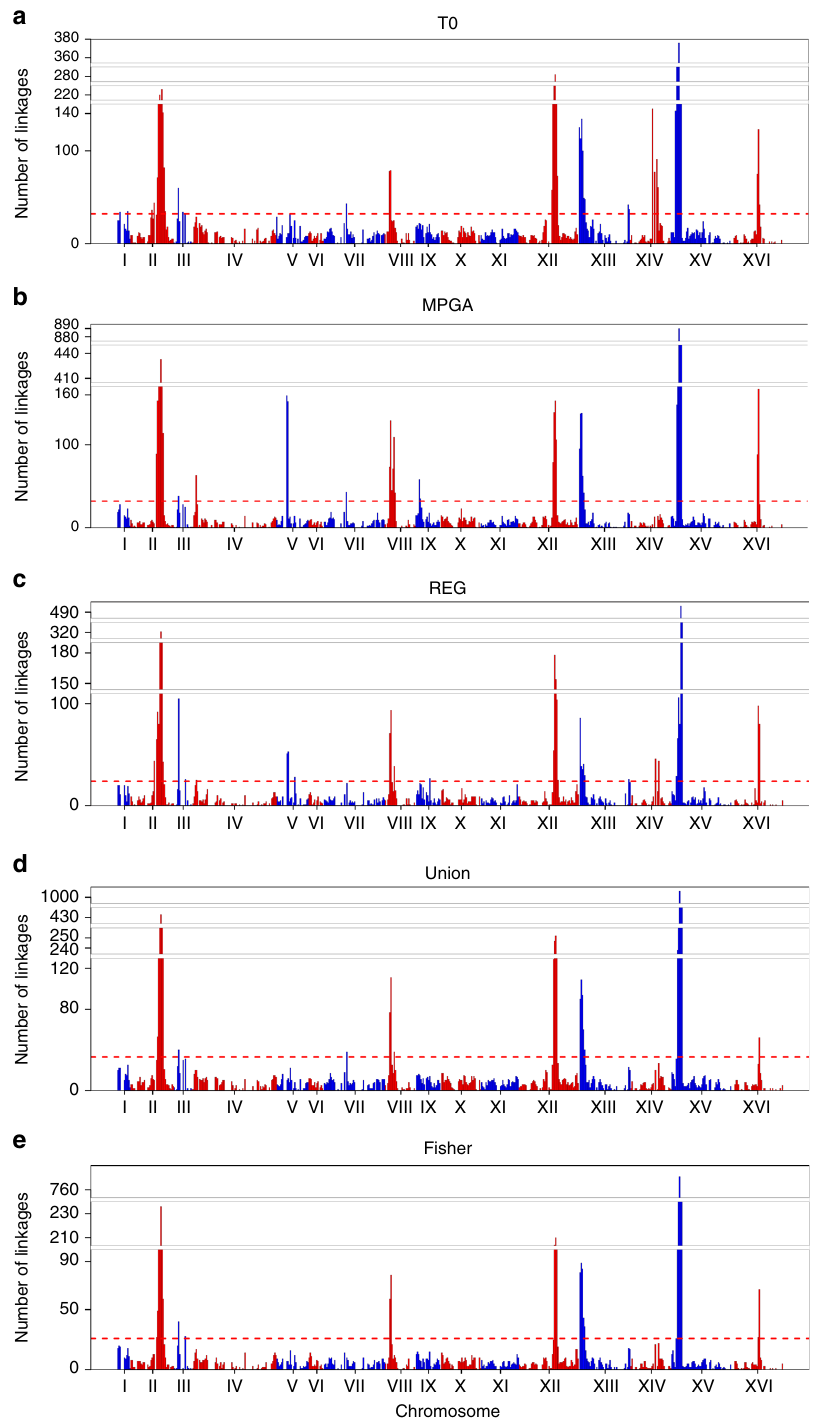
Fig. 3 Number of eQTLs linked to each genome location based on different approaches. The genome was divided into 602 bins of 20 kb each and shown in chromosomal order. The red lines were the cutoff for eQTL hotspot identi fi cation. a The static method; b the MPTGA method; c the regression method; d the union method; e the Fisher ’ s p -value